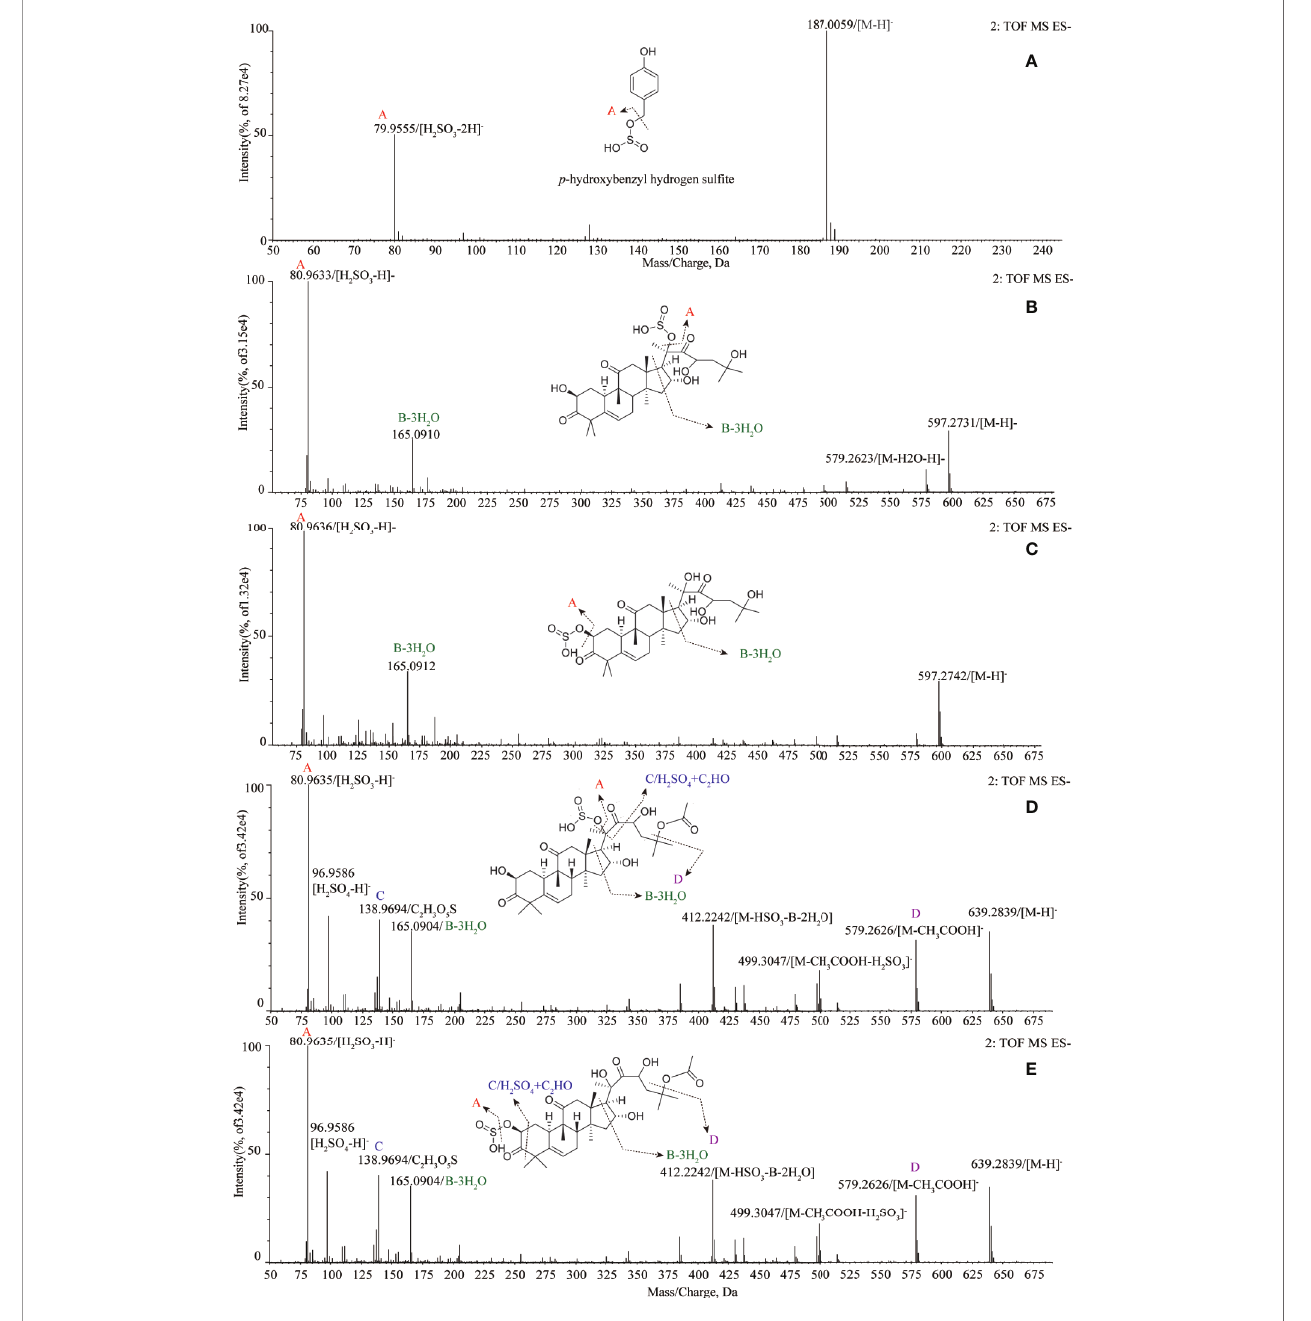
FIGURE 3 | Structural analysis of fi ve sulfur-fumigation markers for TR. (A) pyrolysis debris of p -Hydroxybenzyl hydrogen sul fi te; (B) pyrolysis debris of cucurbitacin D sul fi teI; (C) pyrolysis debris of cucurbitacin D sul fi teII; (D) pyrolysis debris of cucurbitacin B sul fi teI; (E) pyrolysis debris of cucurbitacin B sul fi